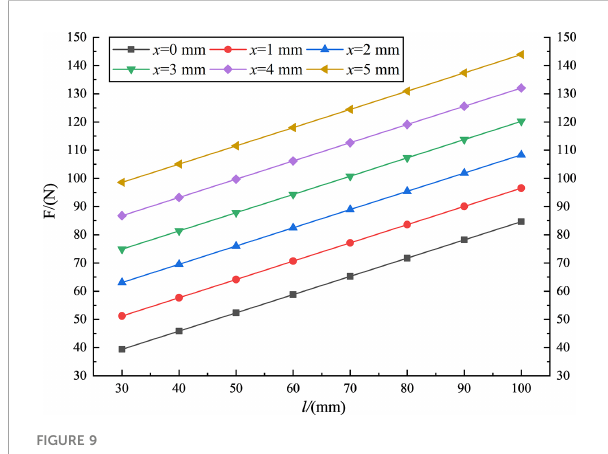
FIGURE 7 In fl uence of pressing displacement on pressing force.